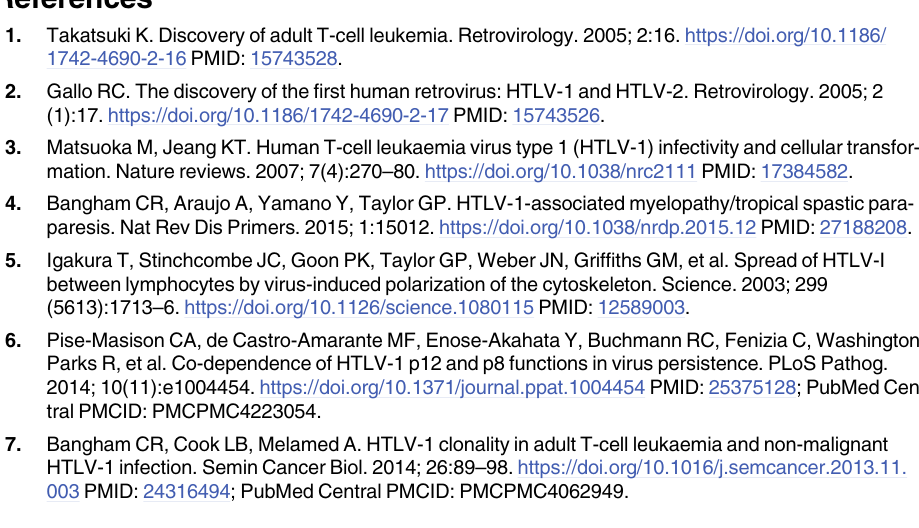
S6 Table. Clonality of HTLV-1 infected cells at different time point. Integration sites of HTLV-1 provirus in various hematopoietic cells and neutrophils at different time point were